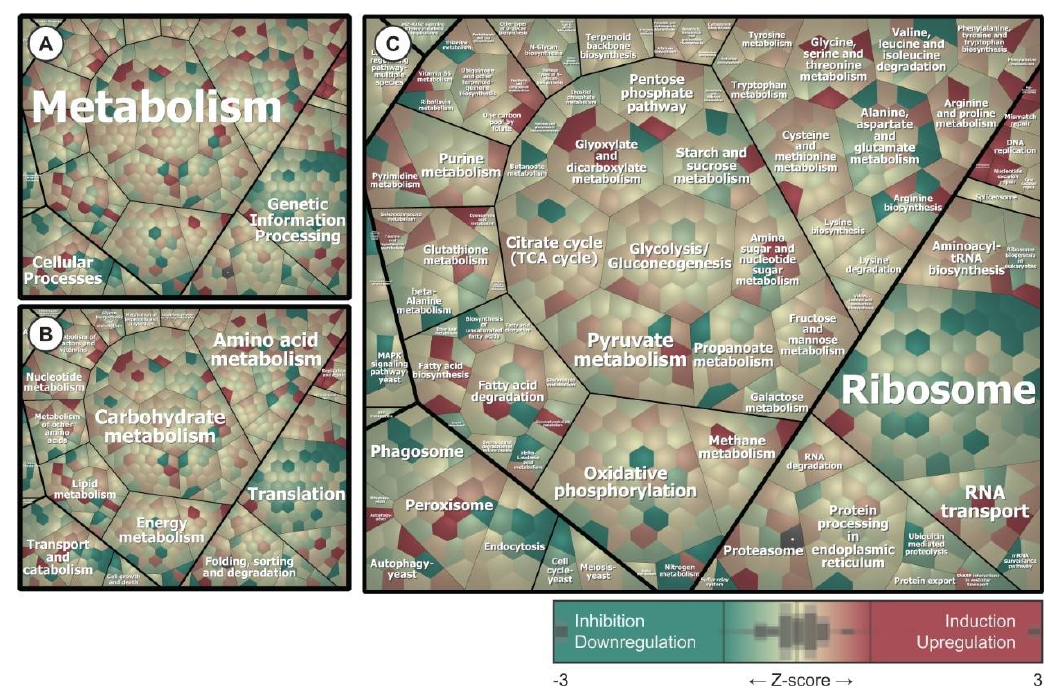
Figure 6. Functional mapping of the cellular proteome revealed targets for DiMIQ in C. albicans biofilms. ( A – C ) Proteins were grouped based on assignments of Kyoto Encyclopedia of Genes and Genomes (KEGG) functional categories. Voronoi treemap layouts were used to visualize identified proteins, which were arranged into smaller clusters inside higher level regions. This hierarchical classification scheme was mapped to a color ramp starting with green (inhibited and downregulated proteins), passing yellow (no significant drug effect) and reaching red (upregulated and induced proteins). Quantitative differences in the proteome are based on calculated Z-score values (Table S1).